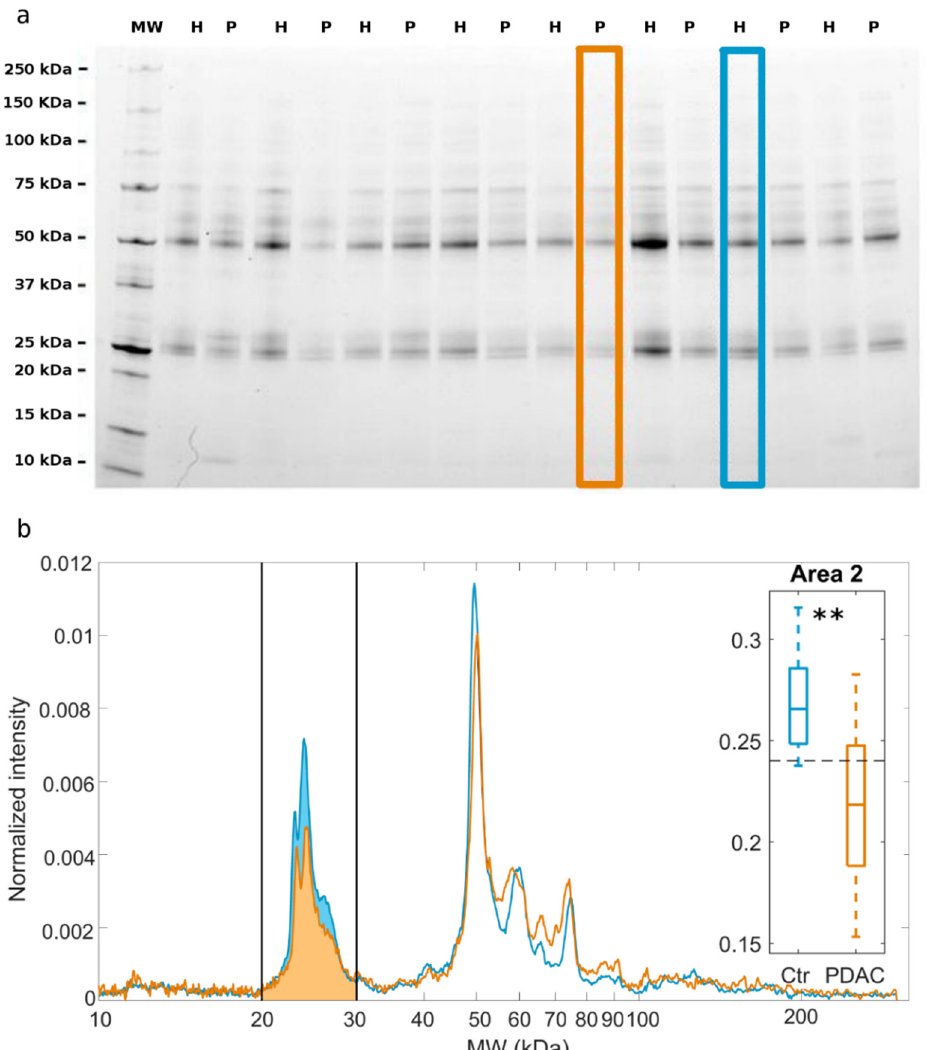
Figure 1. ( a ) Following exposure of graphene oxide (GO) sheets to human plasma, a protein corona forms. After protein corona isolation by centrifugation and protein corona analysis by 1D SDS-PAGE, an image of the gel is obtained. In the gel image, each lane refers to the protein profile from a single human subject, being either a pancreatic ductal adenocarcinoma (PDAC) patient (P) or a healthy volunteer (H). ( b ) 1-dimensional (1D) profiles were obtained by densitometric analysis of the two lanes that are indicated with orange (P) and blue (H) solid boxes in panel a. Black vertical solid lines identify a region of molecular weight between 20 and 30 kDa, hereafter indicated as Area 2, where the largest difference between the two 1D profiles is observed. A boxplot of the computed Area 2 for all the processed samples (34 PDAC vs. 34 healthy subjects) is reported in the inset. Whiskers span from the minimum to the maximum measured values, and boxes indicate the 25th–75th percentile range and horizontal segments represent the median values of the distributions. ** indicate a Student p -value < 0.001.